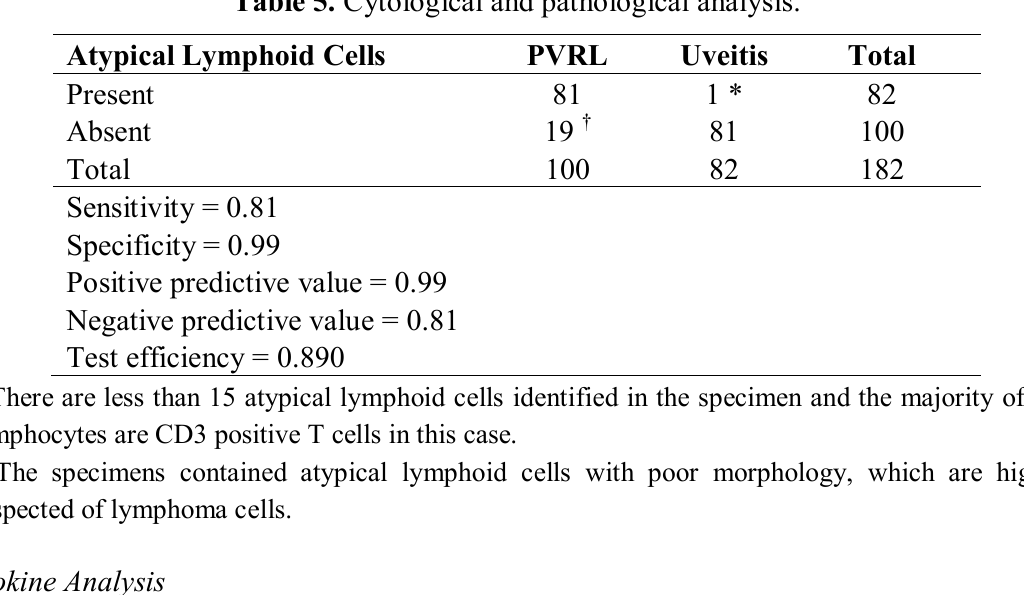
Table 5. Cytological and pathological